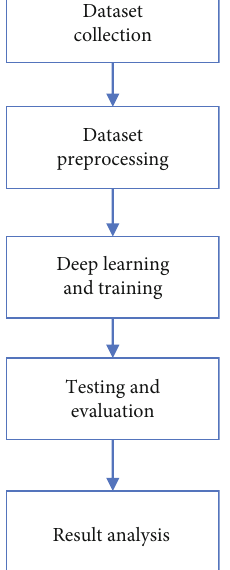
Figure 2: Proposed BMS